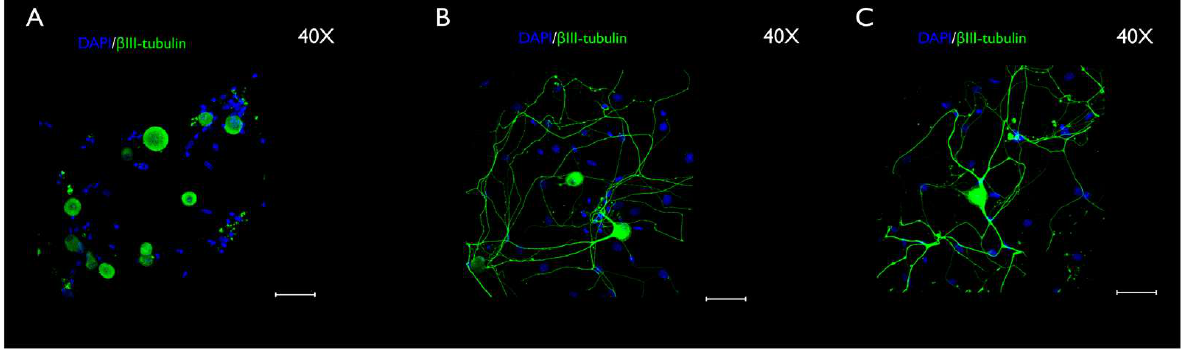
Figure 11. Anti-βIII-tubulin immunocytochemistry performed in cultured TGCs (40× magnification), after 4 h ( A ), 24 h ( B ), and 48 h ( C ). A typical pattern of peripheral neuron immunostaining is illustrated in green. Nuclei immunostaining with DAPI is represented in blue. Over the interval analyzed, neuronal changes, from a round shape, to a highly ramified shape, were observed. Scale bars represent 50 µm.